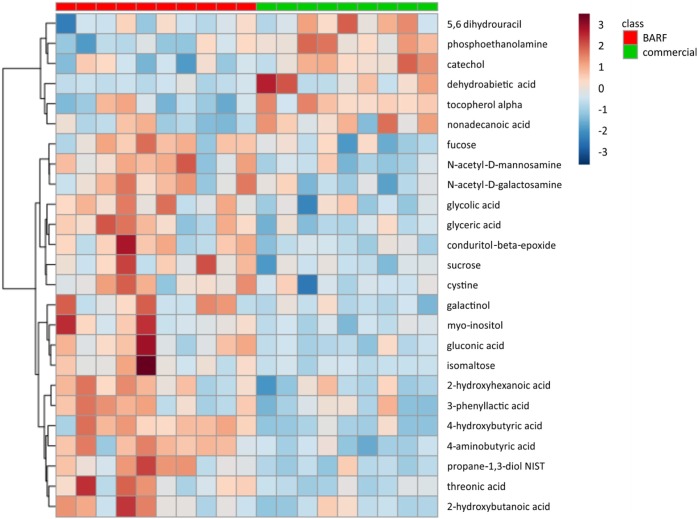
Heatmap of the most abundant metabolites of both groups, as identified by VIP scores in PLS-DA.Every sample (10 BARF samples = red, 9 commercial samples = green) is represented by an own column, the more red colored the higher the abundance of these metabolites. The BARF dogs showed a higher abundance of e.g. myo-inositol, gluconic acid or isomaltose, the commercially fed dogs a higher abundance e.g. of catechol or phosphoethanolamine.